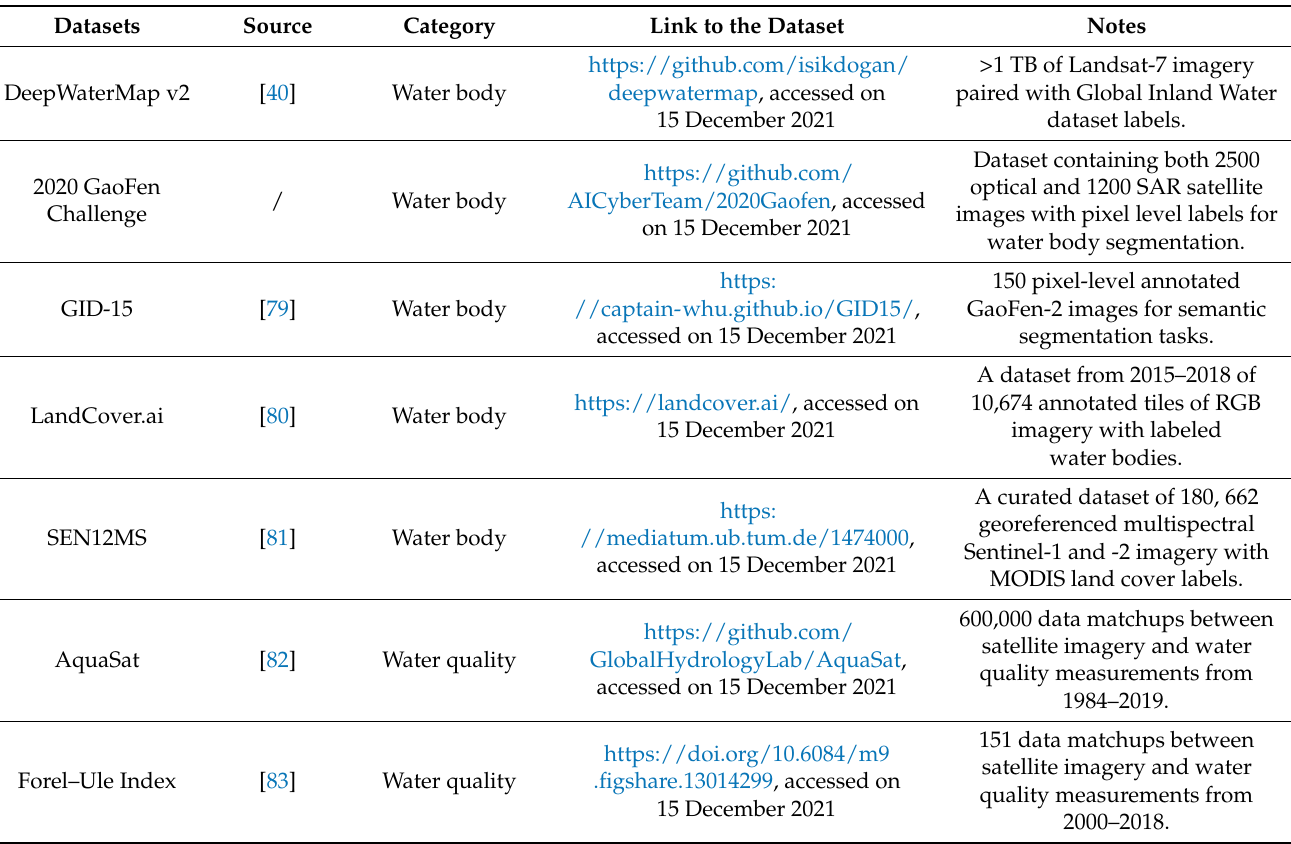
Table 4. Existing datasets for waterbody extraction and water quality